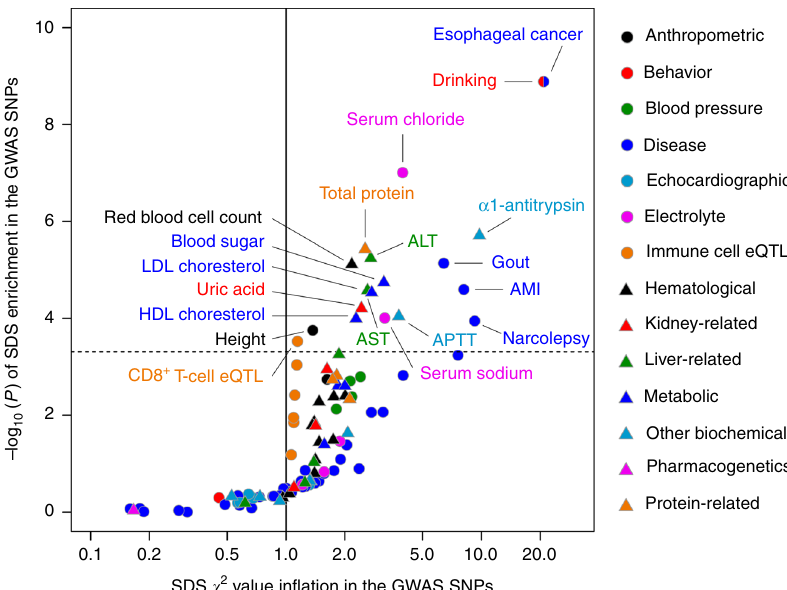
Fig. 5 Overlap between natural selection signatures and genetic risk of human phenotypes in Japanese. Enrichment of the natural selection signatures in the GWAS-associated variants of the diseases ( n = 36), quantitative traits ( n = 61), and immune-cell-speci fi c eQTL ( n = 6) in Japanese. For each trait, in fl ation of the selection χ 2 value is indicated along the x -axis, and – log 10 ( P ) of enrichment is plotted along the y -axis. The horizontal gray line represents signi fi cance threshold based of Bonferroni ’ s correction on the numbers of the evaluated traits ( P <